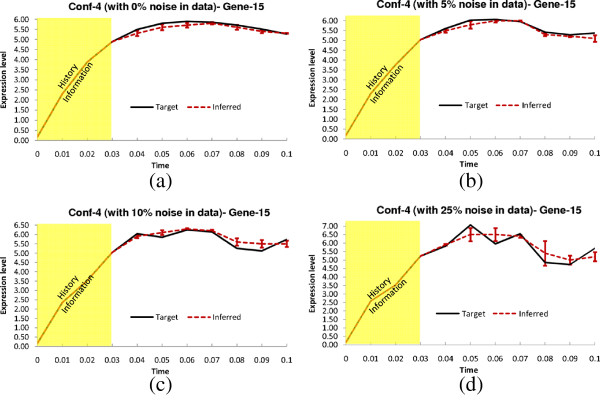
Dynamics for Gene-15 of Conf-4. Solid lines and dotted lines indicate respectively target and inferred (by TDSS) time-expressions in (a) Noise free data (b) 5% Noise in data (c) 10% Noise in data (d) 25% Noise in data. The yellow region indicates the history information and the error bars indicate 95% confidence interval.